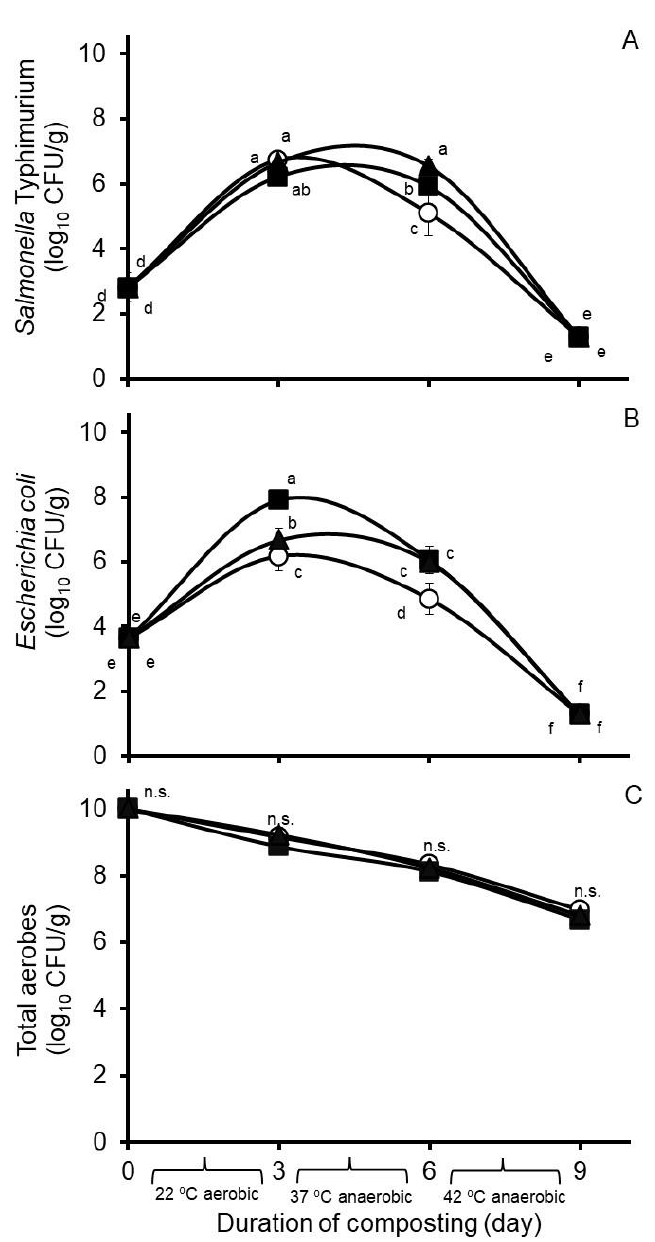
Figure 2. Concentrations in Experiment 1 of Salmonella Typhimurium ( A ), Escherichia coli ( B ), and total aerobes ( C ) during nine days of simulated composting of wood chip poultry litter at 22, 37, and 42 °C. Composts were treated without (circles) or with 0.26% ( wt / wt ) Chinook (squares) or 0.09% ( wt / wt ) Galena (triangles) hops preparations. Values are the least squares means from the treatment by day of compost interaction ± their standard deviations from n = 3 replicated composts at each sample time. Means with unlike lowercase letters differ ( p < 0.05) based on a LSD all-pairwise comparisons test; means not differing significantly are denoted by n.s.